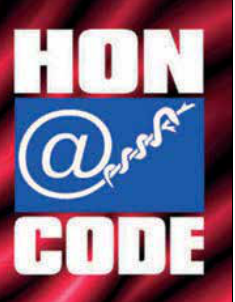
Figure 1. The HONcode/Hon Seal badge or logo (reproduced with kind permission from HON Foundation)